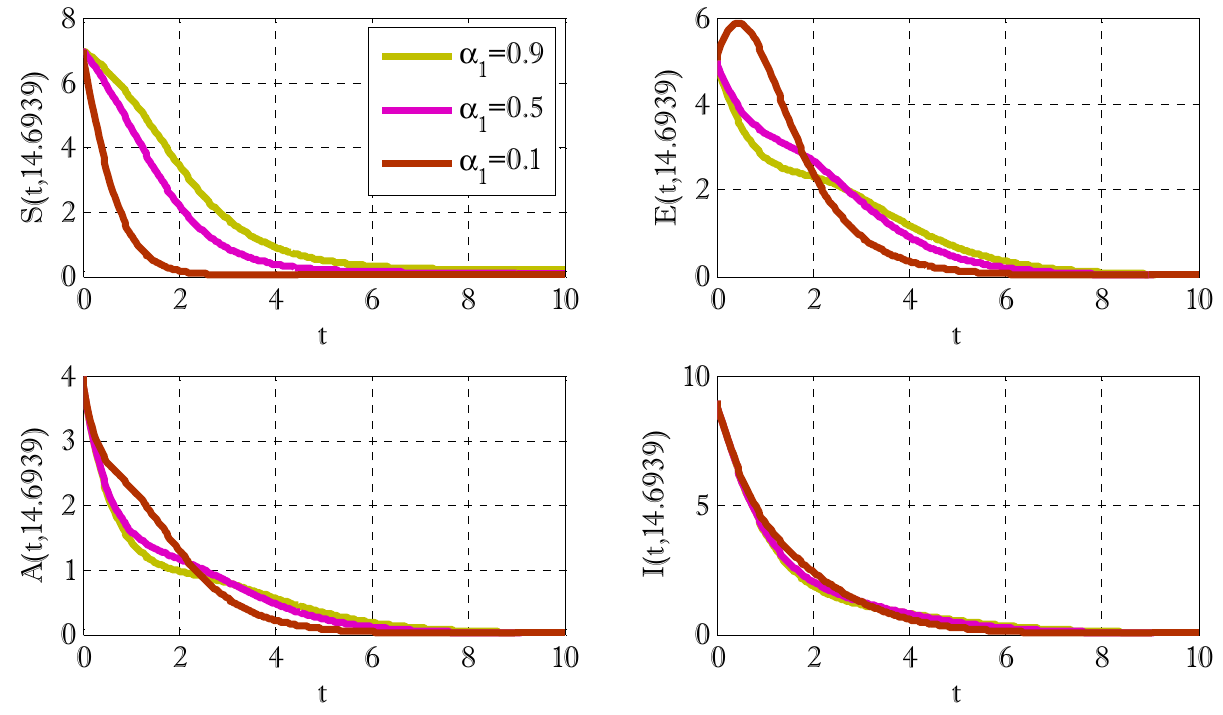
Figure 9. Impact of the bilinear incidence rate parameter α 1 on susceptible, exposed, asymptomatic, and infected individuals using N x = 50, N t = 300, β = 0.9, γ = 0.7, σ = 0.9, µ = 0.9, d 1 = 2, d 2 = 2.5, d 3 = 2.5, d 4 = 2, d 5 = 2, α = 0.9, L =